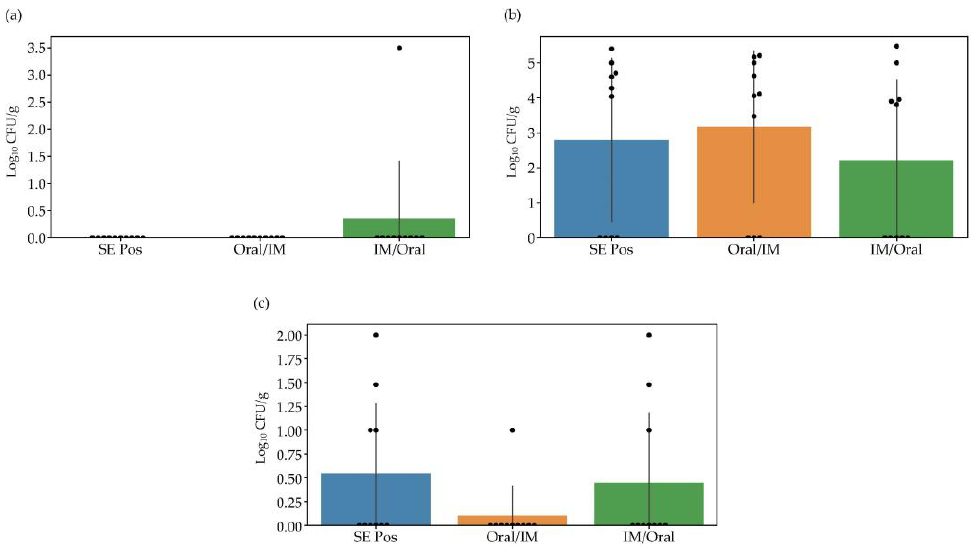
Figure 4. Salmonella titers (log 10 CFU/g) in cecal contents before and after challenge and in the spleen after the challenge. At two weeks after vaccination and one week after challenge, ten chickens were euthanized and the Salmonella titers in the cecal contents and spleens were determined. ( a ) Cecal contents two weeks post booster vaccination ( p = 0.38), ( b ) Cecal contents one week post-challenge ( p = 0.66), and ( c ) Spleen one week post-challenge ( p = 0.28). Spleen tissues of chickens before challenge were used for ELISpot assay. SE Pos—non-vaccinated but challenged group; Oral/IM— prime-boost vaccinated group with the candidate strain via oral–intramuscular route; and IM/Oral— prime-boost vaccination with the candidate via intramuscular–oral